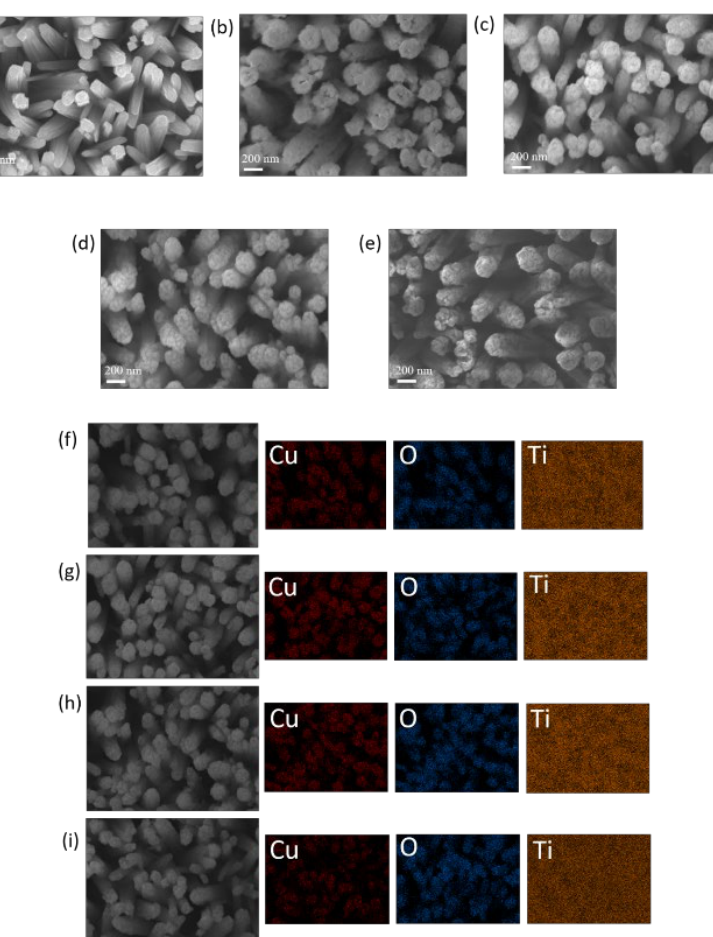
Figure 1. SEM images: ( a ) TiO 2 , ( b ) TC200, ( c ) TC300, ( d ) TC350, and ( e ) TC400. Corresponding Cu, O, and Ti mapping images of the composite nanorods: ( f ) TC200, ( g ) TC300, ( h ) TC350, and ( i ) TC400.